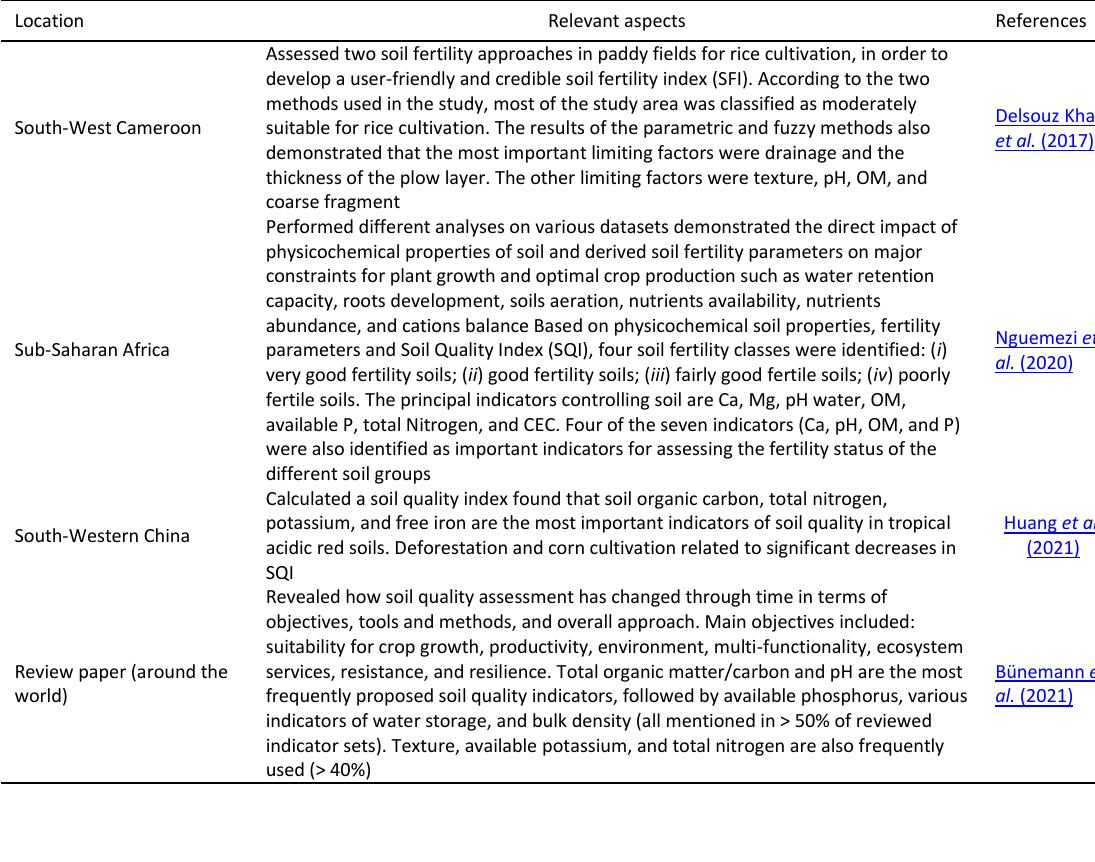
Table 1: Summary of different recent studies about soil quality.